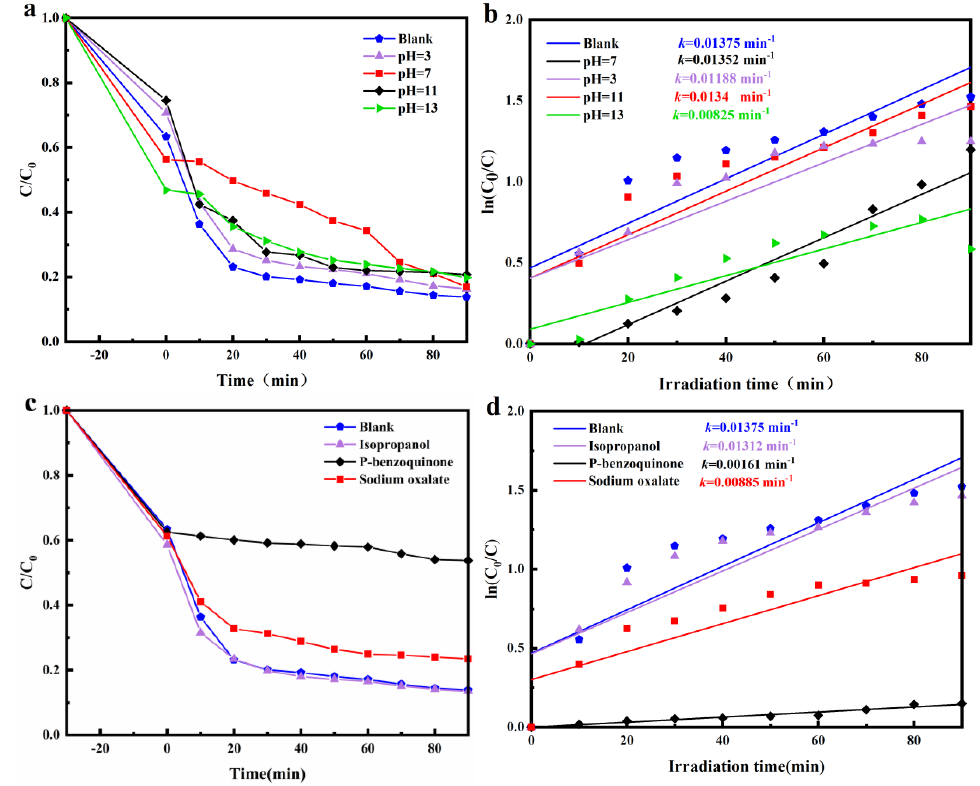
Figure 8. Photodegradation rates of TC (10 mg/L) in solutions containing ZnO@Bi 5 O 7 I (2:1). ( a , b ) Solutions with different pH, ( c , d ) Solutions with various organic compounds.